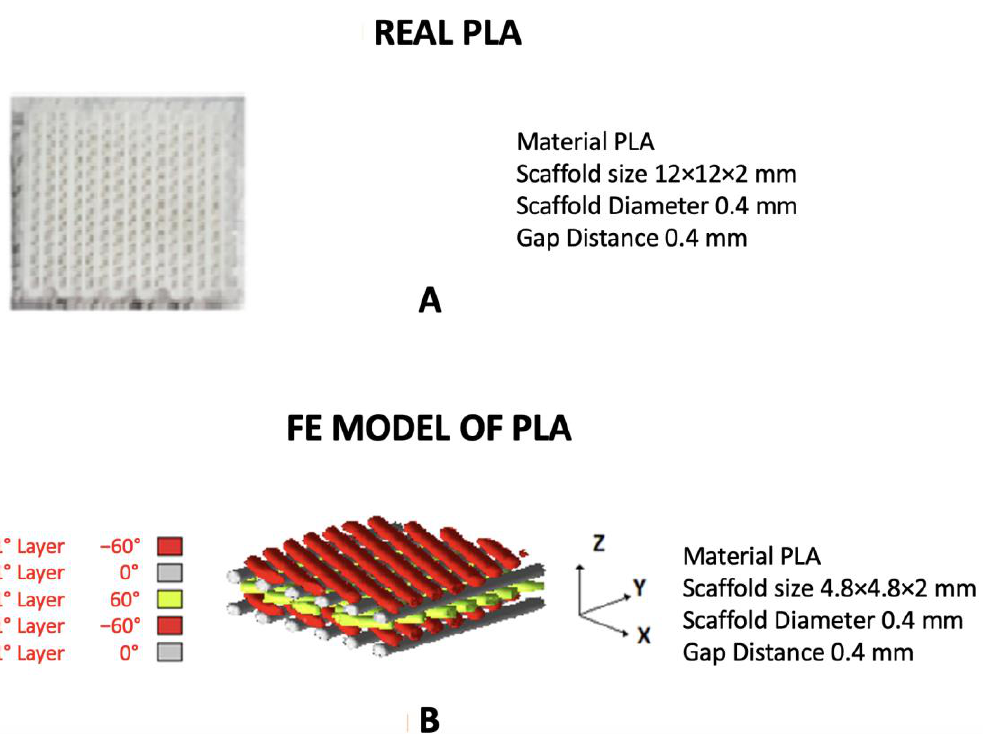
Figure 1. Representation of the 3D-printed scaffold with geometric characteristics ( A ), and the virtual model with layers orientation ( B ).